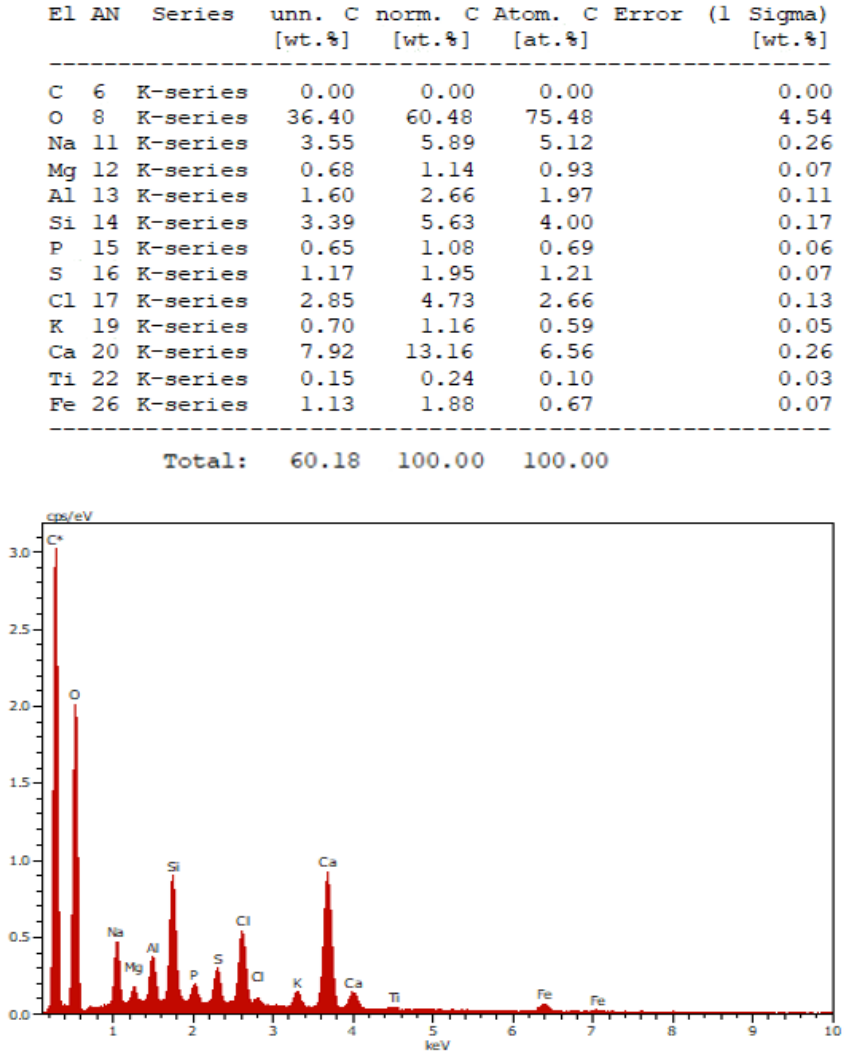
Figure 4. Energy dispersive X-ray analysis of the depositions (School of Dentistry, National and Kapodistrian University of